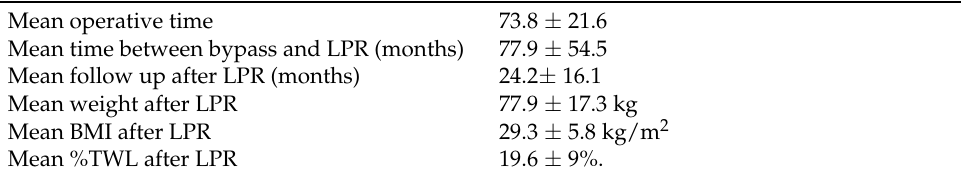
Table 2. Peri-operative and postoperative